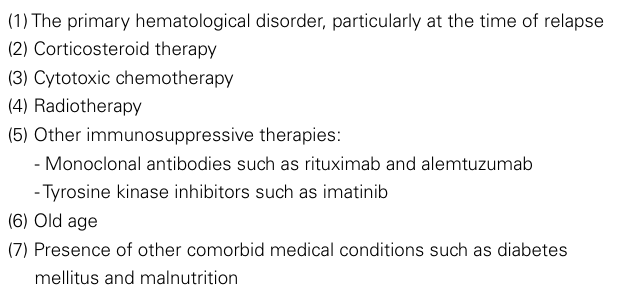
Table 2 | Risk factors for M. tuberculosis infections in patients with HM